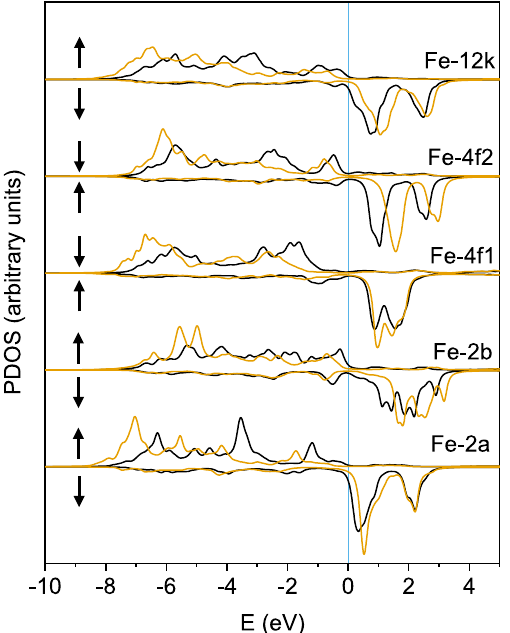
Figure 3. Spin-resolved PDOS for the five Fe sublattices computed at two different U values: 0 eV (black lines) and 3 eV (yellow). For each sublattice the majority spin component along the positve y -axis and the minority along the negative y -axis are plotted. Notice that since the 4 f 1 and 4 f 2 sublattices are antiferromagnetically coupled to the rest, their up and down spin directions (indicated by arrows at the left of each plot) are